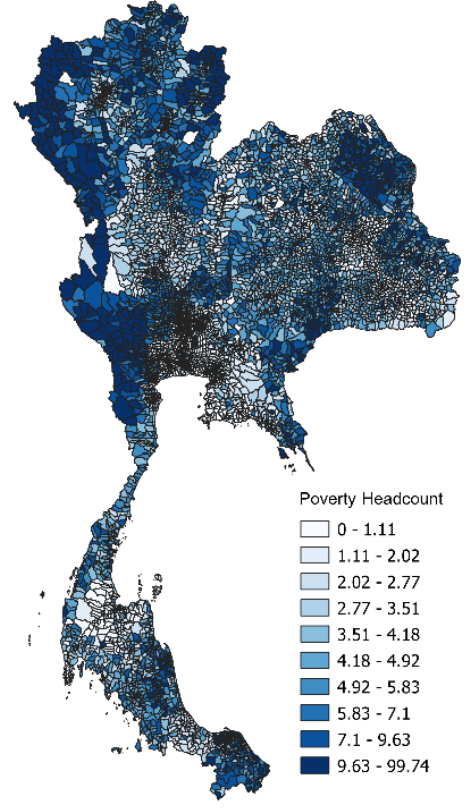
Figure 8. Spatial distribution of poverty headcount in 2017. Source: Thailand’s NSO.